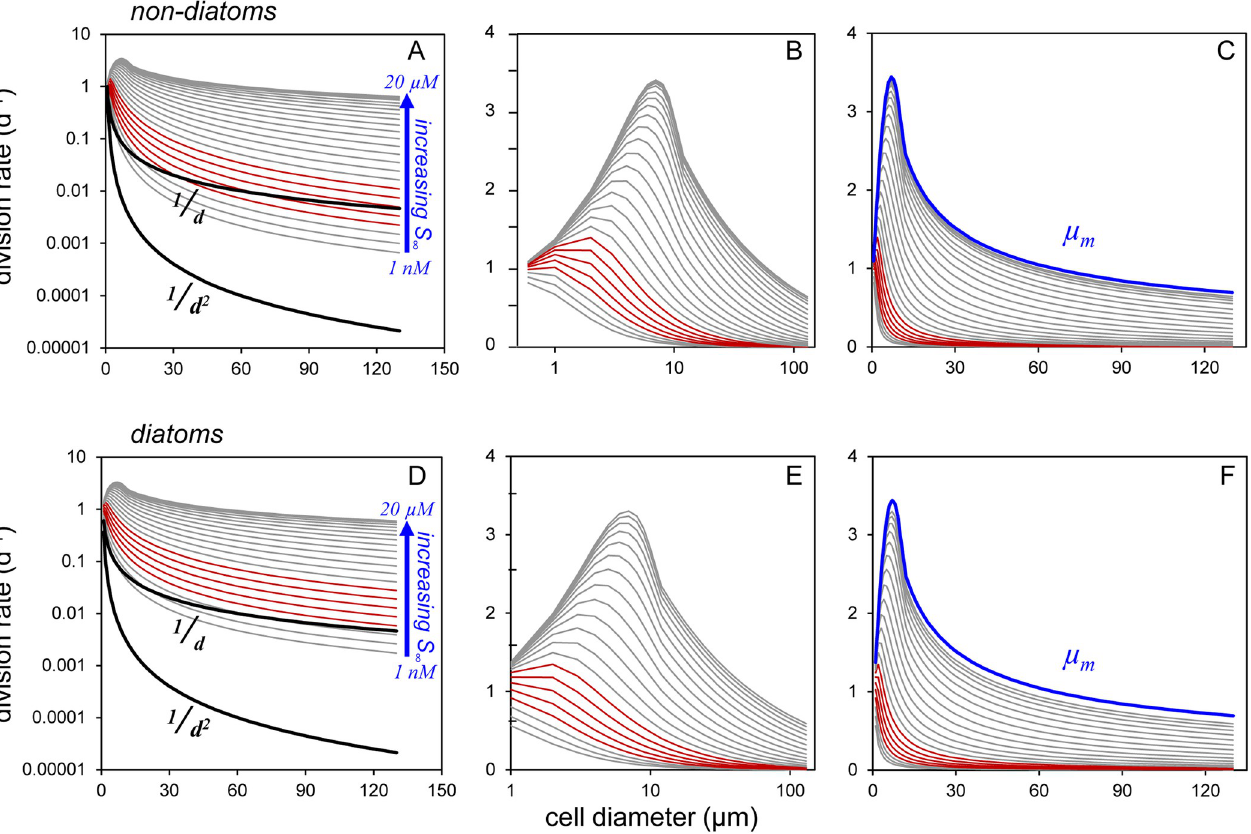
Fig 3. Diffusion-supported phytoplankton division rates as a function of cell size predicted for a range in far-field nutrient concentrations ( S 1 ) reflective of highly oligotrophic to highly eutrophic natural waters. (A-C) Non-diatoms. (D-F) Diatoms. (A,D) Lower heavy black line = initial prediction for diffusion-limited growth at all cell sizes. Upper heavy black line = division rate prediction if following cellular surface:volume ratios. Grey lines = size- dependent division rates for S 1 ranging from 1 nM to 3 μ M (blue labeling). Red lines = division rates for biologically-available nitrogen concentrations of 3 nM to 17 nM typical of S 1 values in oligotrophic ocean gyres. (B,E) Same data as in left column but with normal y-axis and log-transformed x-axis to better reveal size-dependent division rates of small cells. (C,F) Same data as in left column but with normal axes. Blue line = envelope in size-dependent maximum division rates ( μ ) from Behrenfeld et al. m